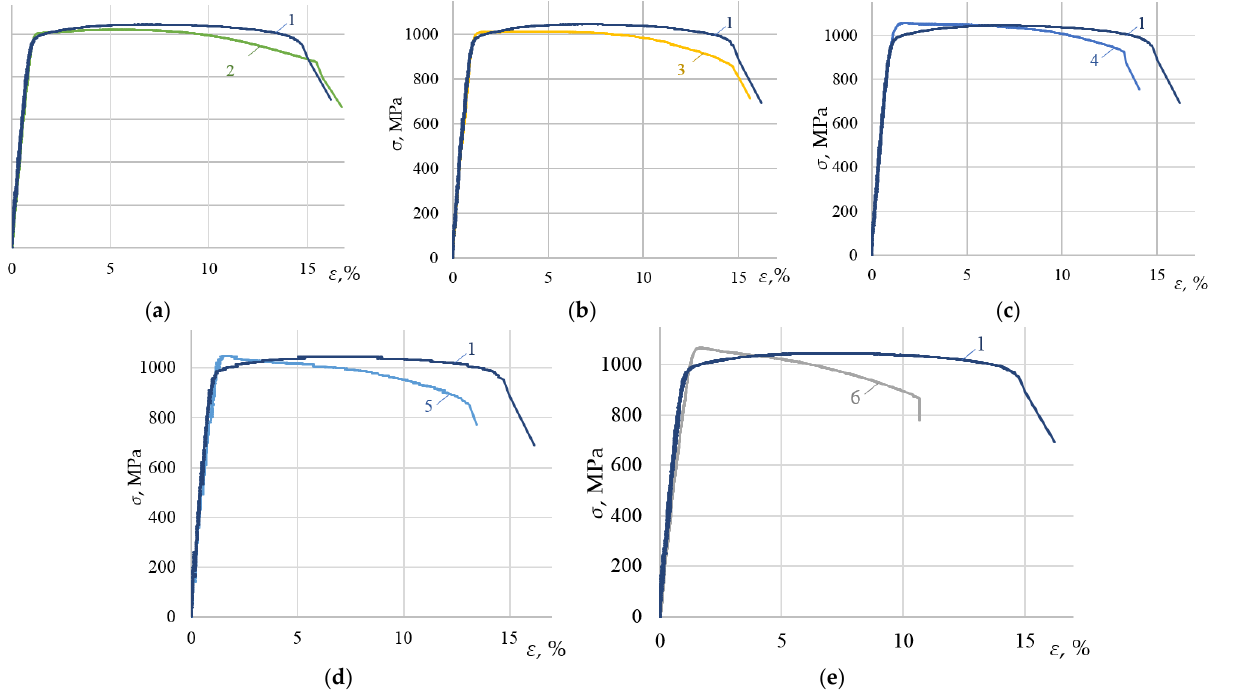
Figure 2. Static tensioning of specimens: 1—longitudinal rolling; 2—transverse rolling.